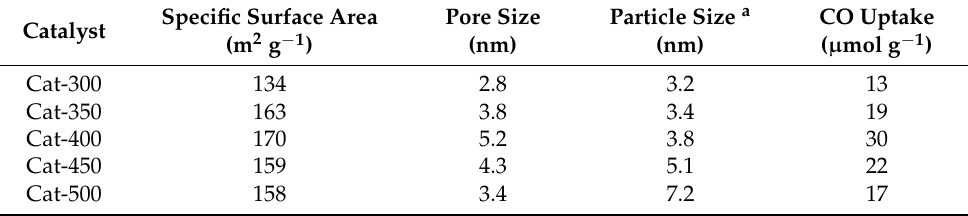
Table 3. Textural and structural property of different Ni 2 P/Al 2 O 3